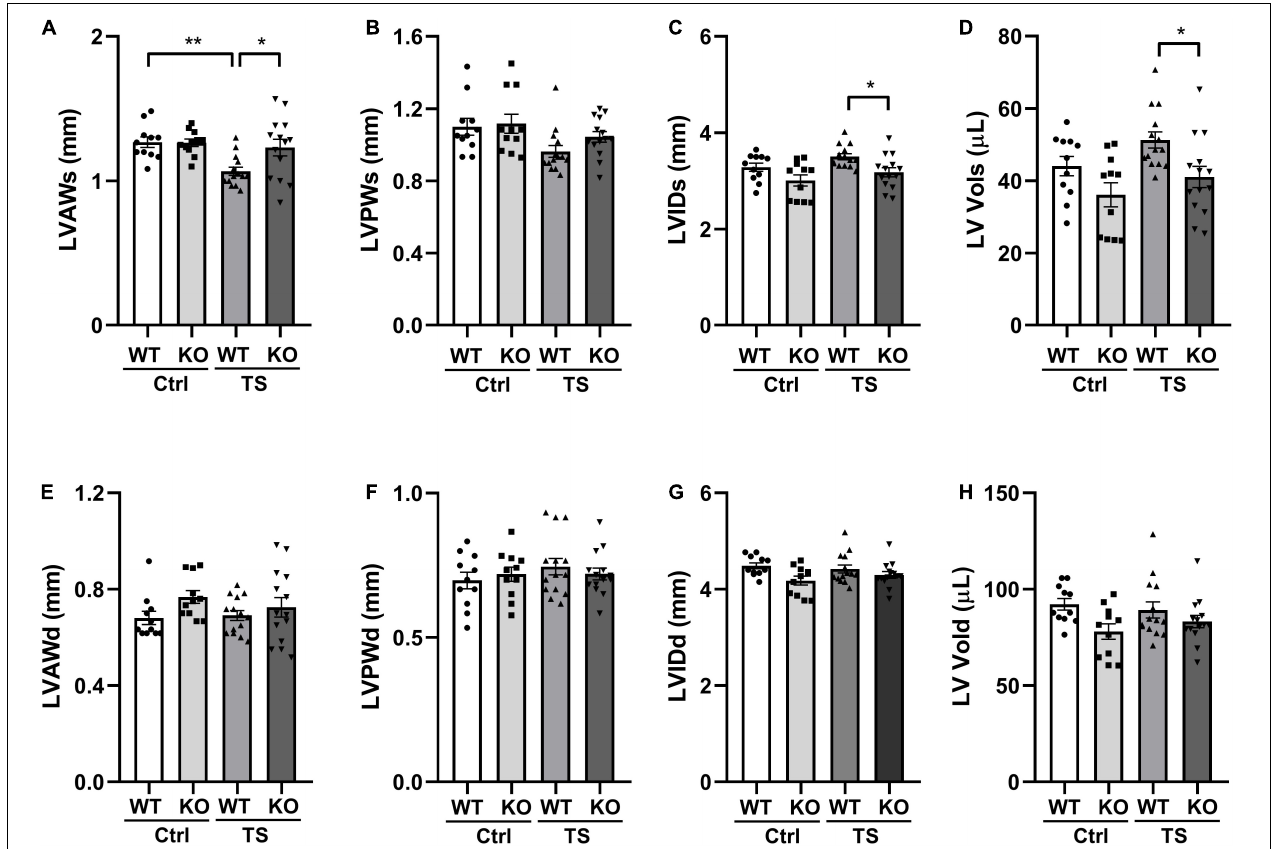
FIGURE 3 | The left ventricular structure of WT and WWP1 KO mice after tail suspension. (A–H) Quantitative analysis of the diastolic and systolic left ventricular posterior wall thickness (LVPWd and LVPWs), LV anterior wall thickness (LVAWd and LVAWs), LV internal diameter (LVIDd and LVIDs), and LV volume (LV Vold and LV Vols) from WT and WWP1 KO mice by echocardiography following tail suspension. Data represent the means ± SEM. * P < 0.05, ** P < 0.01. Ctrl, control; TS, tail suspension; WT, wild-type mice; KO,